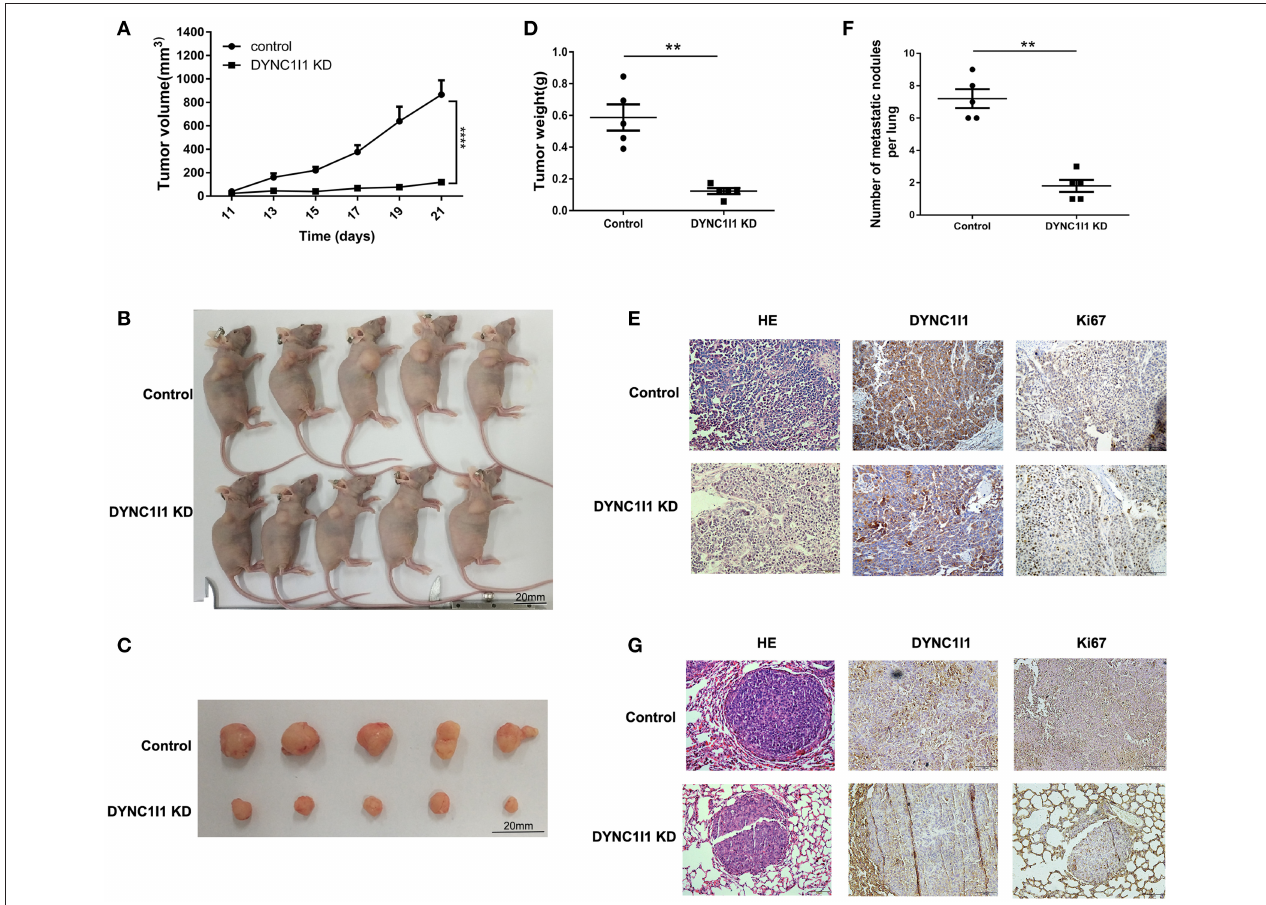
FIGURE 4 | DYNC1I1 leads to promotion of gastric cancer progression and migration in vivo . (A) In vivo growth curve of xenografts formed by subcutaneous injection of SGC-7901 cells stably transfected with NC, KD DYNC1I1 into the dorsal flanks of nude mice ( n = 5 for each group). (B) and (C) Representative images. (D) Tumor weight. (E) HE and representative immunohistochemistry (IHC) staining with DYNC1I1 and Ki67 in subcutaneous tumor tissue. (F) Lung metastatic colonization of nude mice treated with tail vein injection of SGC-7901 cells stably transfected with NC, KD DYNC1I1. (G) HE and representative immunohistochemistry (IHC) staining with DYNC1I1 and Ki67 in lung metastatic tumor tissue. Ki67:nuclear related antigen Ki67 (** P < 0.01, **** P < 0.0001, student t -test, n = 5 for each group).